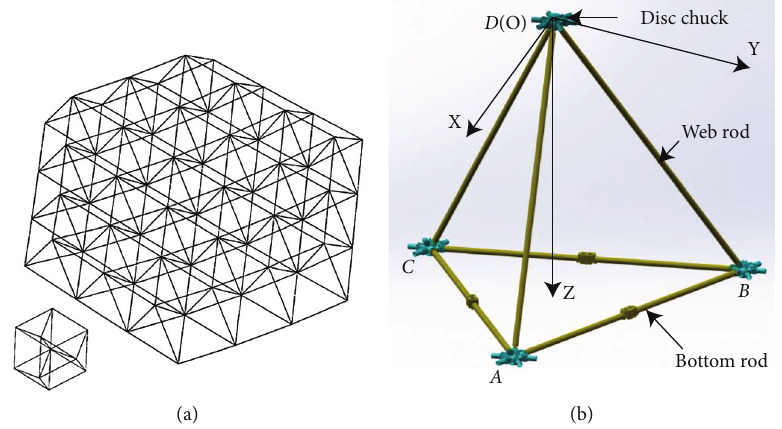
Figure 1: Antenna truss diagram: (a) truss antenna; (b) tetrahedral element.